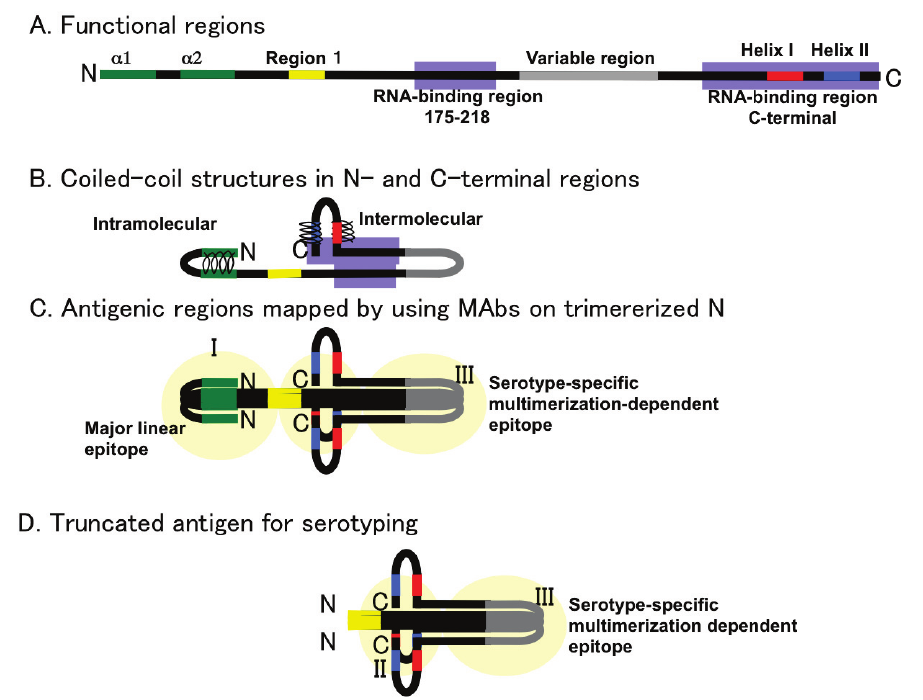
Figure 4. A schema of trimerized hantavirus N. A. Functional regions of N were plotted